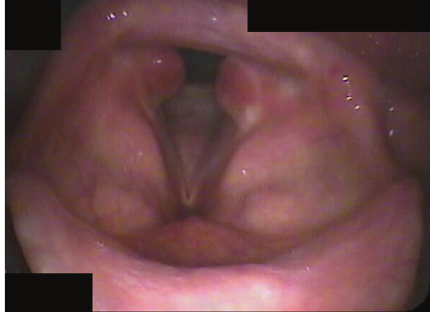
Figure 1: Early bilateral granulation tissue after intubation.